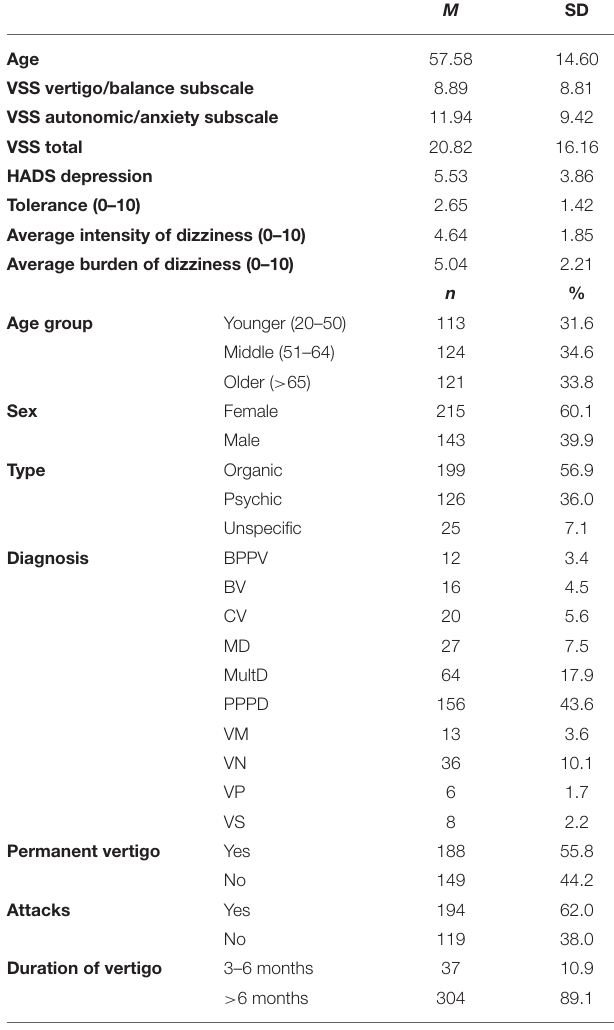
TABLE 1 | Overview of descriptive